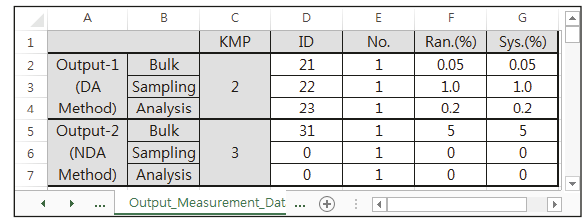
Figure 3: Example of input format (Excel file) for configuration of measurement